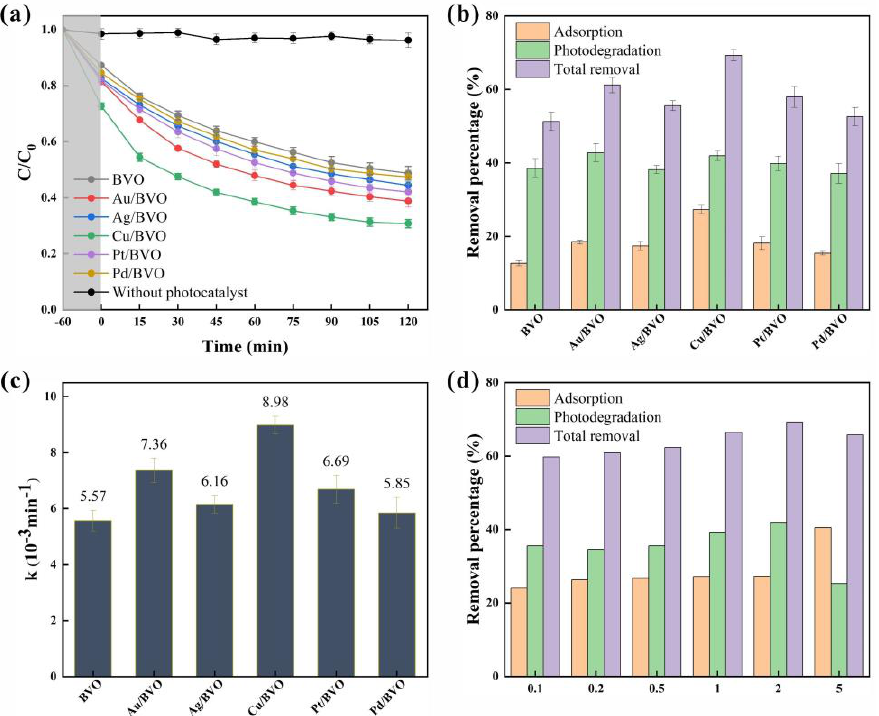
Figure 7. The photocatalytic performances of bare and modified BVO in the degradation of TC: ( a ) adsorption−photocatalytic degradation process; ( b ) removal rate; ( c ) the histogram of first-order rate constant k; ( d ) influence of copper content on the photocatalytic performance of Cu/BVO.